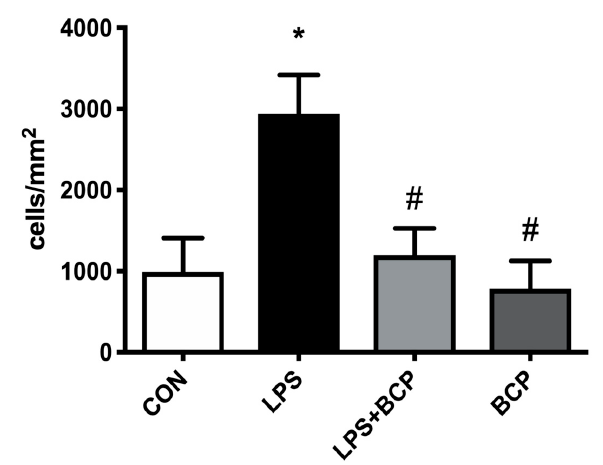
Figure 7. Leukocyte adhesion in submucosal bladder venules of female BALB/c mice for the following experimental groups: control (CON; n = 5), LPS-induced IC (LPS; n = 5), LPS-induced treated with oral BCP (100 mg/kg, LPS + BCP; n = 5), healthy animals administered oral BCP (100 mg/kg, BCP; n = 5). All groups were pretreated with olive oil gavage, with the treatment groups receiving BCP dissolved in olive oil. Saline and LPS were administered via intravesical instillation. Data presented as mean ± SD. * p < 0.05 vs. Control, # p < 0.05 vs.